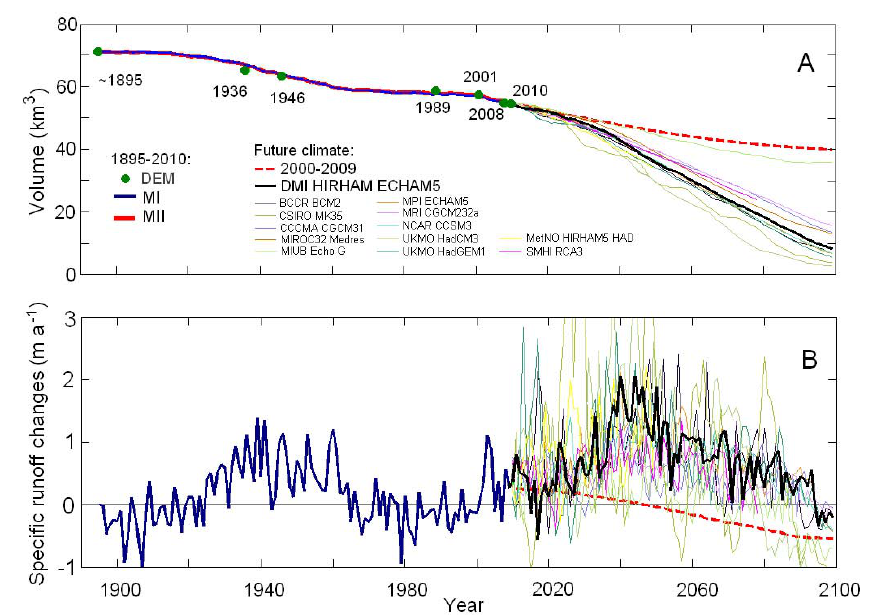
Fig. 11. (A) Simulated evolution of Hoffellsjökull ice volume during the 20th and 21st centuries, initiated with the observed LIA max glacier geometry. The green dots are volume estimates from DEMs. The volume change 1895–2010 is simulated by using the T and P records in Fig. 6 and the two methods MI (blue curve) and MII (red curve) for implicit and Weertman type sliding, respectively. The future evolution is computed with MI by using the climate scenarios in Fig. 8 and by maintaining the average climate of 2000–2009 (dashed red curve). (B) Simulated specific runoff anomalies (precipitation and glacier melt) relative to the specific runoff at the start of the simulation (2.5ma − 1 in 1895) from the area covered by the LIA max glacier ( ∼ 234km 2 ). Negative values indicate smaller runoff than at the start of the simulation.